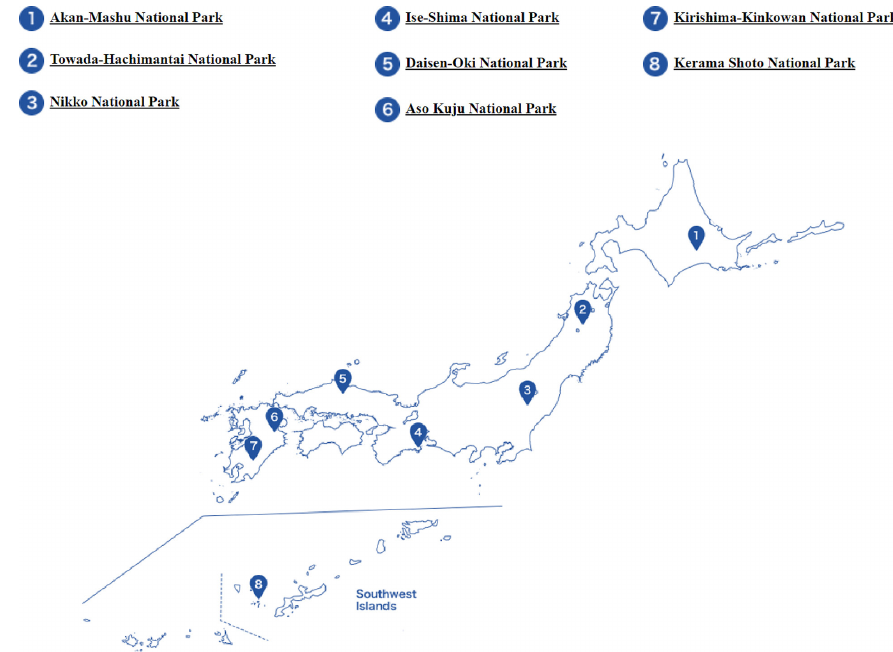
Fig. 2. Location of eight national parks in the Ministry of Environment’s programme. The map was retrieved from the Ministry of Environment’s website (http://www.env.go.jp/en/nature/enjoy-project/index.html) and edited by the authors for better clarity. Source: own